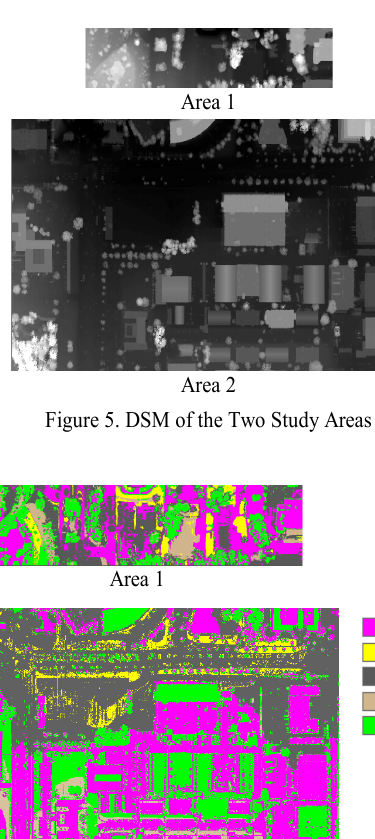
Figure 7. Classification Results of the Point Format Data